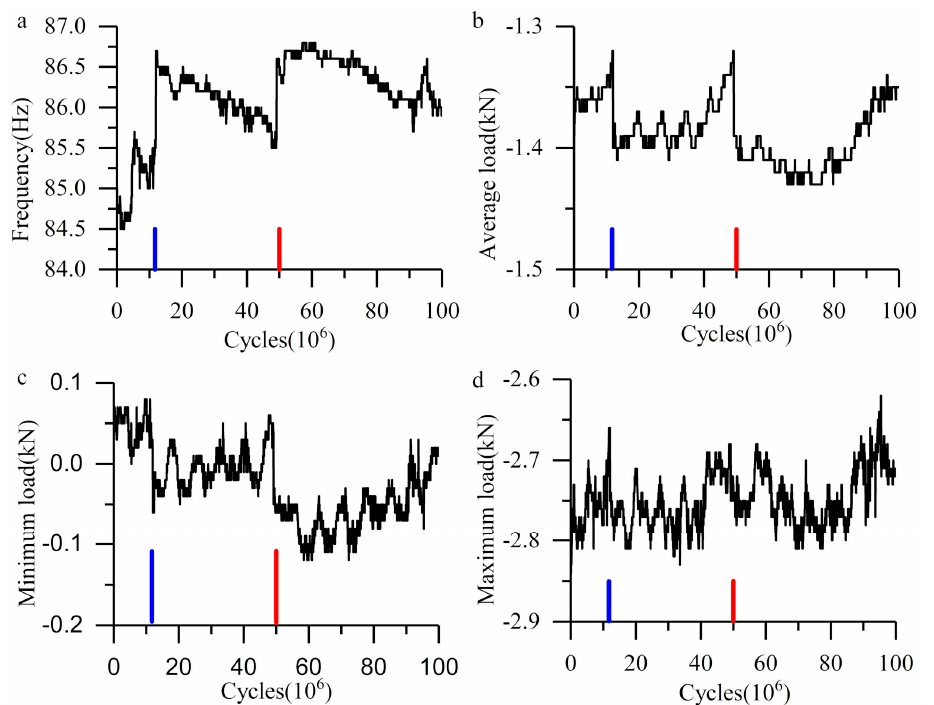
Figure 2. Load and frequency curve in the plate-ball system. ( a ) Frequency curve; ( b ) average load curve; ( c ) minimum load curve; ( d ) maximum load curve.